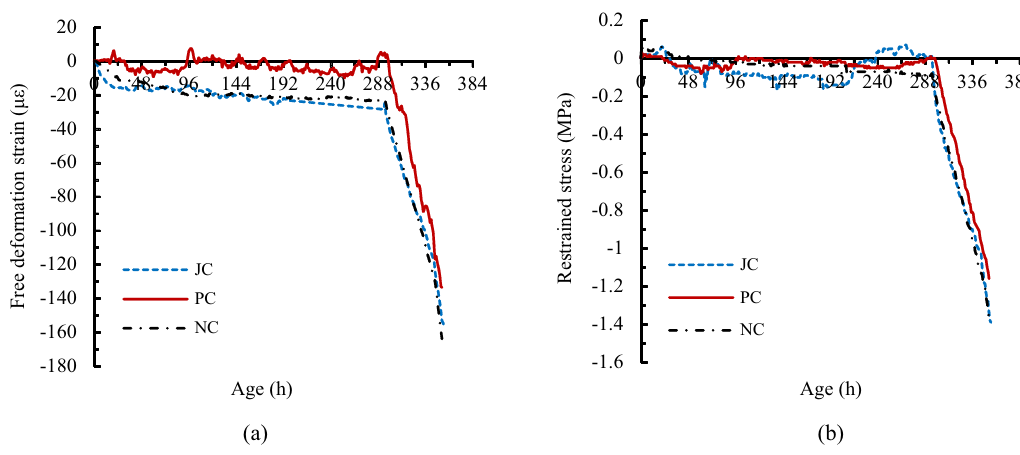
Figure 6: ( a ) Free deformation strain and ( b ) restrained stress curves of the three concretes under CTC